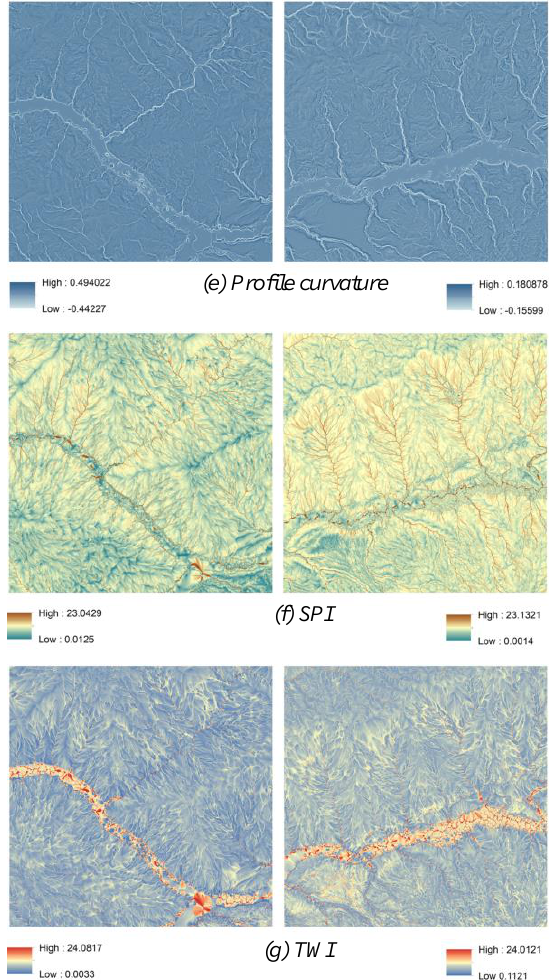
Figure 4. Topographical parameters of the study area: (a) altitude, (b) aspect, (c) slope, (d) plan curvature, (e) profile curvature, (f) SPI, (g)